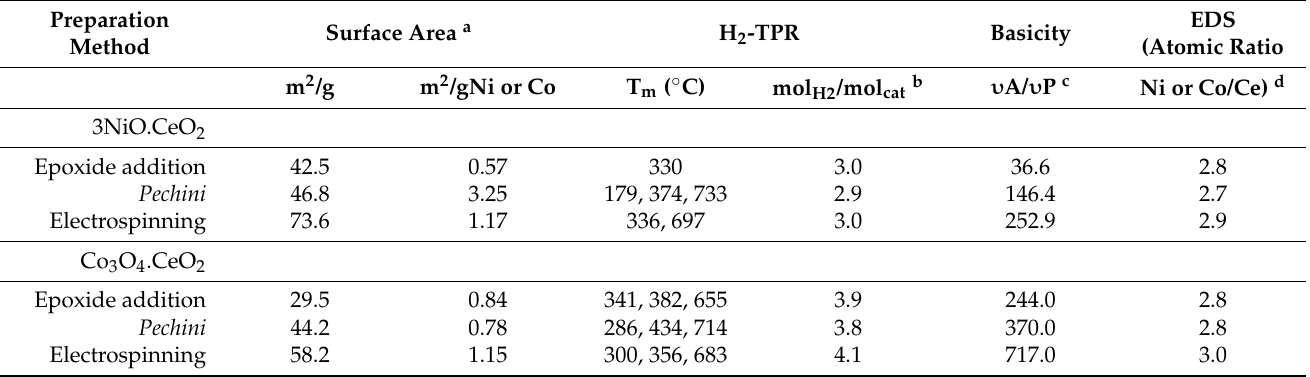
Table 1. Characterization of nickel– and cobalt − cerium bimetallic oxides by BET, H 2 -TPR, SEM/EDS,